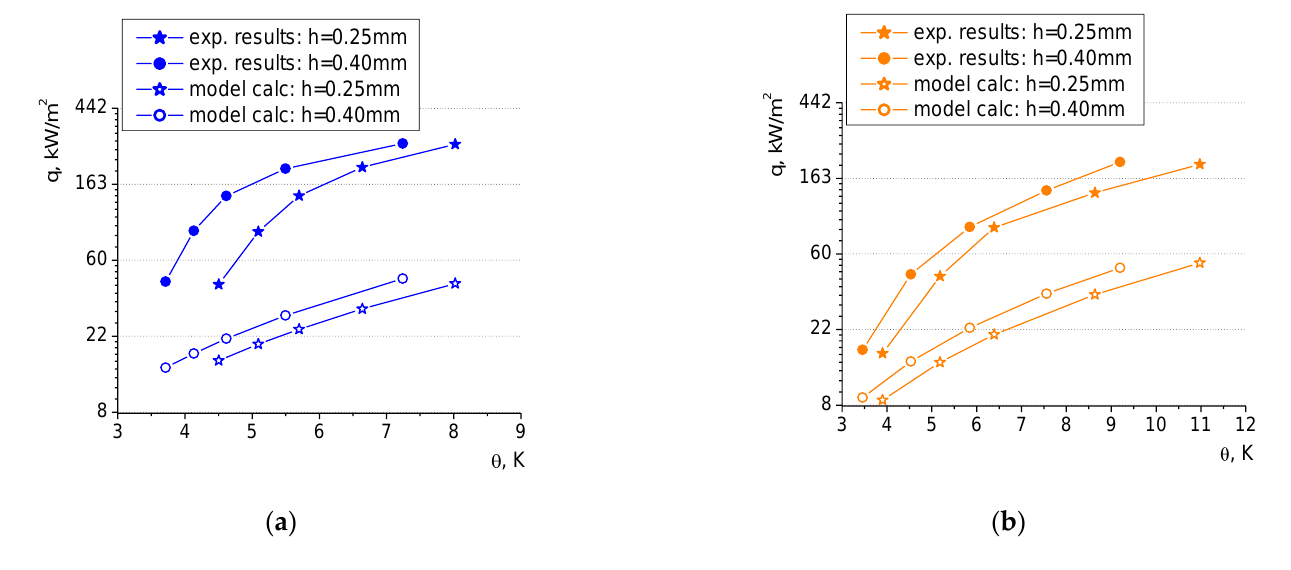
Figure 22. Comparison of the experimental and calculated results for ( a ) water and ( b ) ethyl alcohol. As can be seen, the model underestimates the values of heat flux (especially in the case of water). For example, the actual values of water boiling heat flux recorded at the superheat of 5.5 K during measurements on surfaces covered with 0.4 mm and 0.25 mm microfins were, respectively, 6.6 and 5.3 times higher than the calculation results obtained with the model. In the case of ethanol and the same superheat of 5.5 K, the discrepancies were lower and the respective values were 3.7 and 3.4. Generally, in the whole range of superheats, the experimental data were higher than the results of model calculations by 2.7–6.9 times for water and by 1.9–4.0 times for ethanol. However, the model provides quite consistent results and the nature of heat flux changes is quite well-reflected. Thus, a modification to this model has been proposed. Namely, due to a different geometry of the laser-made grooves, “z” will equal “w” (the laser grooves are fully open to the liquid as opposed to the original model, in which the gap at the top was small due to the microfins’ shape in the form of a “T”) and s = w + a. Moreover, the values of two constants in Equation (4) have been determined for the laser-processed samples: C (which would consider the unique feature of surface roughness at the bottom of the laser-treated samples) as well as constant p (which is related to the properties of a given liquid and how it interacts with a laser processed surface; Figure 22 indicates the influence of the liquid used for heat flux determination). Using the fitting procedure for the experimental results of 80 data points (taken from the current paper and [42]), the following constants have been found for the laser-processed surfaces: C = 9.11 and p = 0.79. Figure 23 presents the comparison of the experimental and calculated values for the original and modified model. The red dashed lines indicate full agreement with the model (q calc = q exp ), while the green lines are ± 100% agreement bands. The original model provided weak agreement with the model (as was also indicated in Figure 22), while in the case of the modified correlation, almost all data points are within the ± 100% agreement bands. It needs to be added that the above modification of the model originally proposed by Xin and Chao (for a different type of microstructure) provides higher accuracy than a modified correlation developed by the authors, based on the concept of a matrix of equivalent microfins (as originally presented by Smirnov [44]). Thus, it seems that the convection-based model of boiling heat transfer might be more applicable to laser-treated